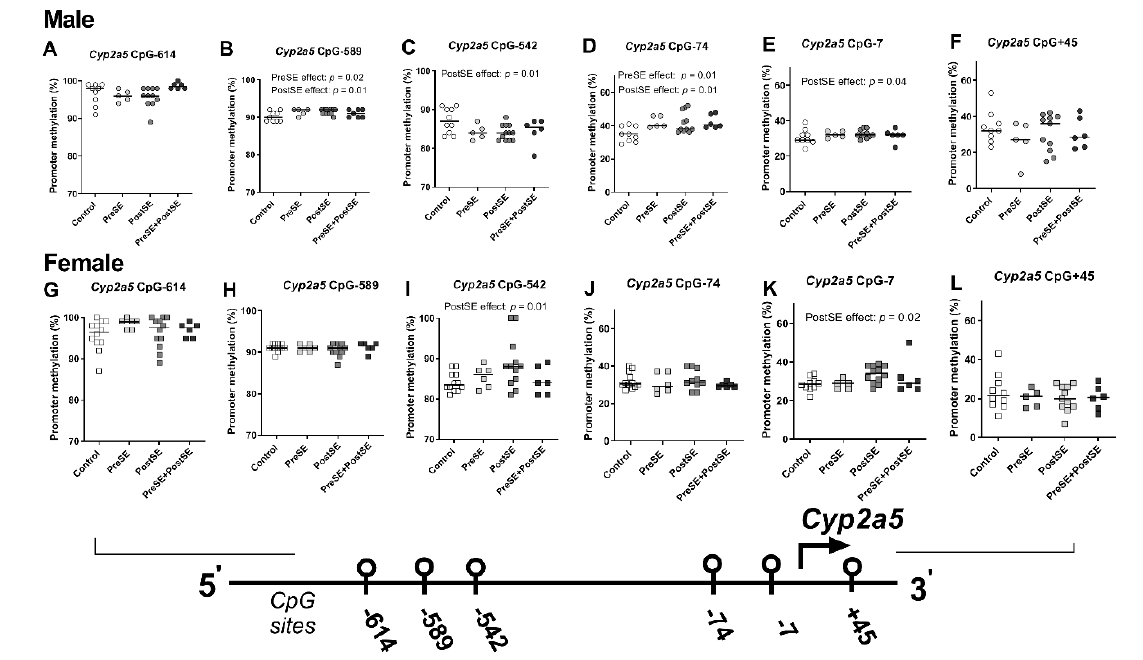
Figure 3. Sex-dependent Cyp2a5 promoter methylation in the liver from (prenatally) smoke exposed- and control groups. DNA was isolated from whole liver of male ( A – F ) and female ( G – L ) and from smoke exposed (prenatal and/or postnatal: closed symbols) and control groups (open symbols). DNA was subjected to bisulfite sequencing-based methylation analysis of the Cyp2a5 promoter region and the percentage of DNA methylation was assessed. Data of the 6 targeted CpG-sites are presented per sex and exposure as individual values with median as a horizontal line. CpG-site annotations are relative to the ATG start codon. If not stated otherwise, the comparison of shown groups was not significant. A linear regression analysis was performed among allgroups. Circle ( ○ ) symbol(s) = male, square (□) symbol(s) = female. Open symbol(s) = control group, closed symbol(s) = (prenatally) smoke exposed group.